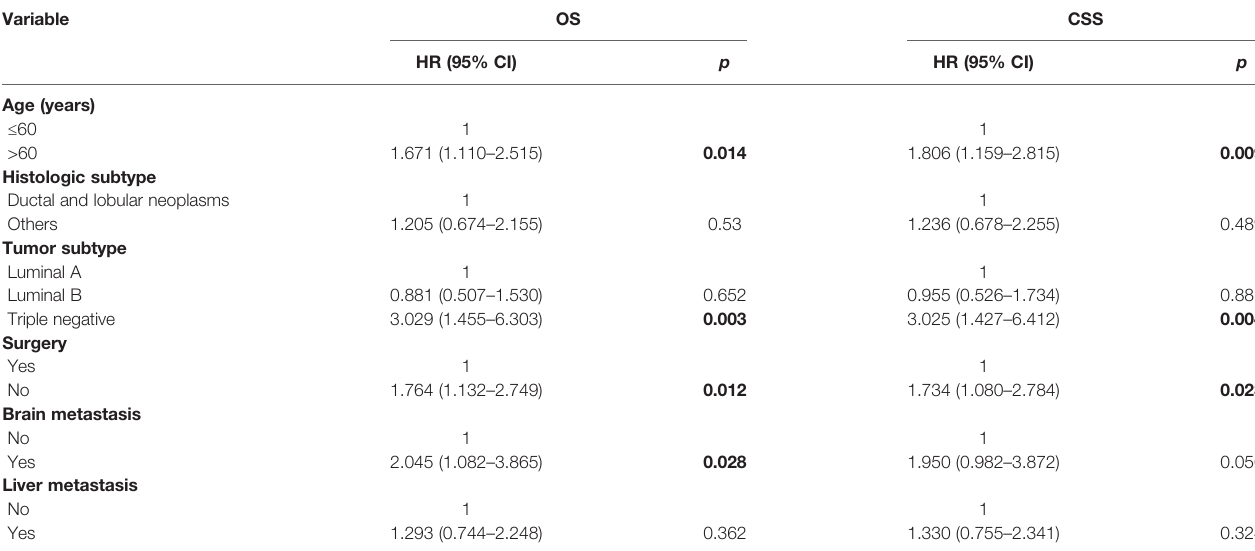
TABLE 3 | Multivariate Cox analysis of variables in male breast cancer with bone metastasis.